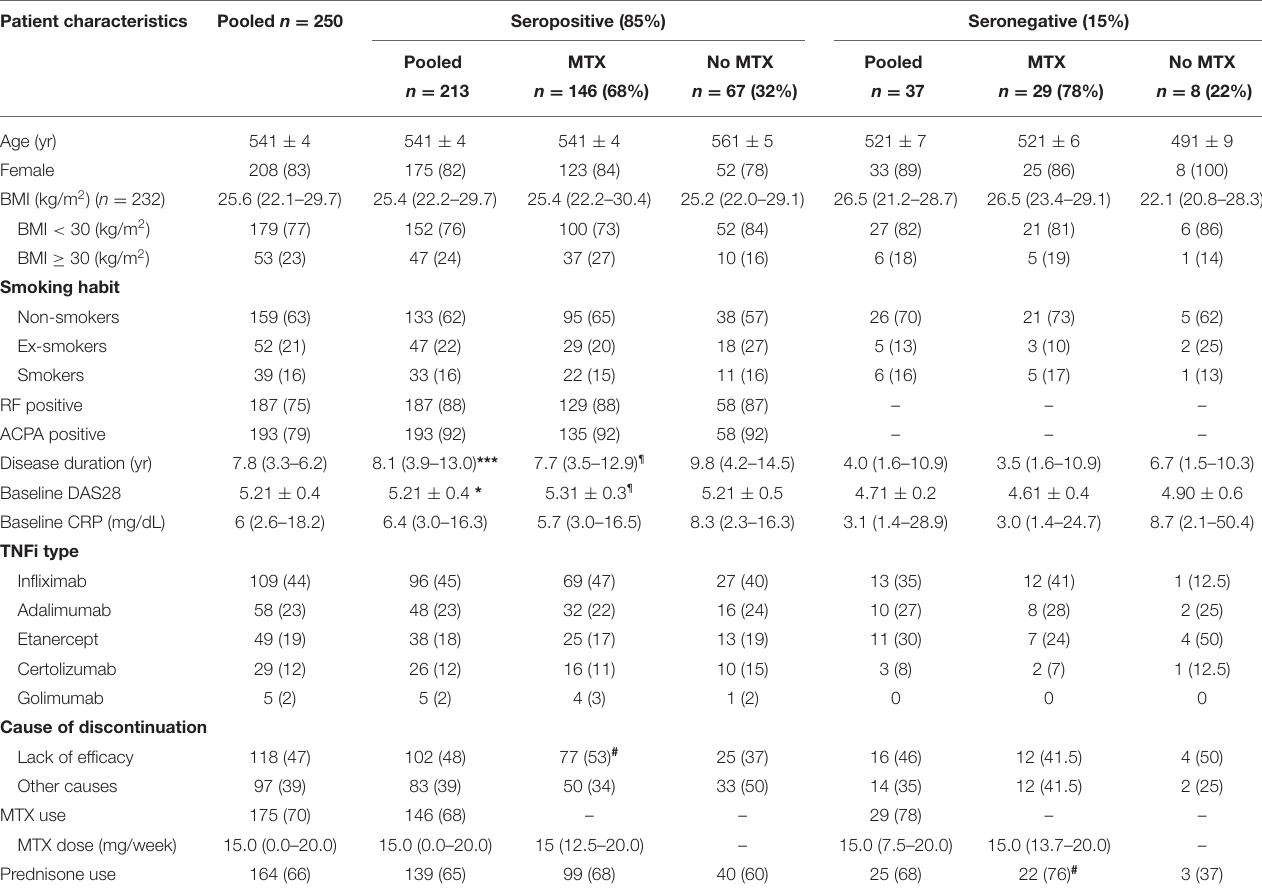
TABLE 1 | Patient